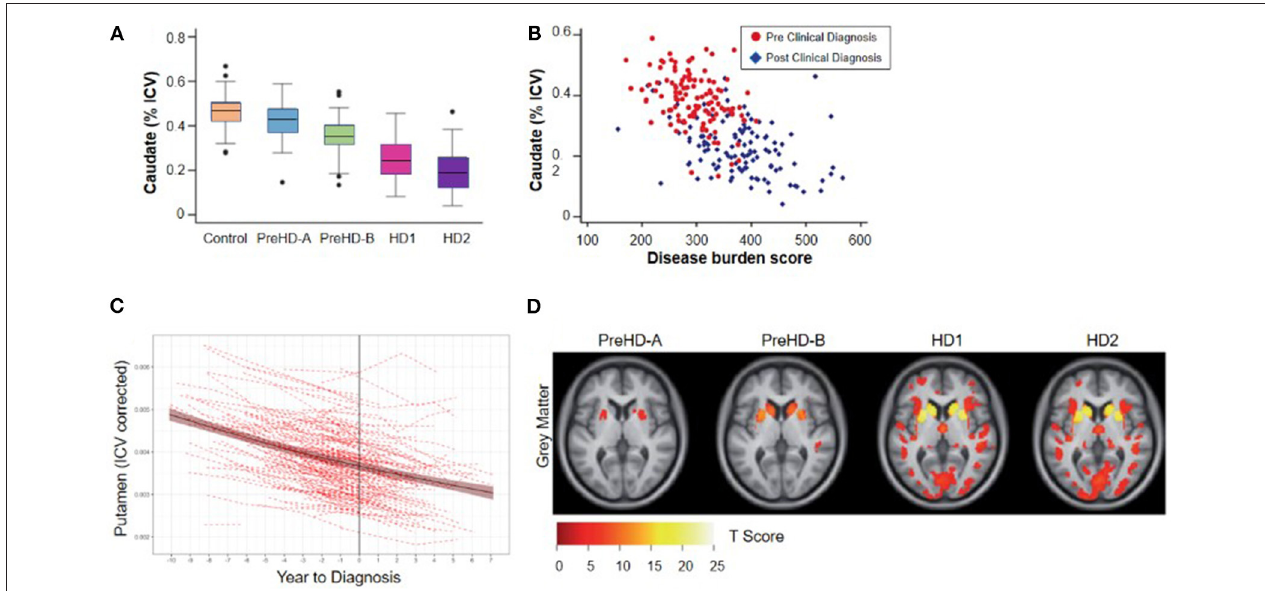
FIGURE 2 | Cross-sectional relationship between regional brain volume loss from vMRI and disease progression. (A) Regional volume analysis shows a monotonic decrease in caudate volume as a function of TRACK-HD cohort. The group of individuals without clinical motor diagnosis at baseline were divided at the median into PreHD-A (further from predicted diagnosis) and PreHD-B (nearer to predicted diagnosis). HD1: participants with a clinical motor diagnosis and TFC 11-13; HD2: participants with a clinical motor diagnosis and TFC 7-10. (B) Regional volume analysis shows an inverse correlation with disease burden score [age*(CAG length-35.5)] over all groups of participants; similar results were found for putamen and whole striatum ( 4). (C) Trajectory of putamen volume for N = 225 participants who received a clinical motor diagnosis during PREDICT-HD. Shown are the individual dashed empirical curves and the solid fitted spline curve with the 95% confidence interval. The vertical line indicates the year of clinical motor diagnosis (set to year = 0). (D) Whole-brain VBM analysis of baseline data from the TRACK-HD shows that the strongest differences from controls are concentrated in the striatum including the caudate. The figure displays statistical parametric maps of gray matter differences in each group compared with controls with the data adjusted for age, sex, study site and intracranial volume. Results are corrected for multiple comparisons using familywise error at the p < 0.05 level (